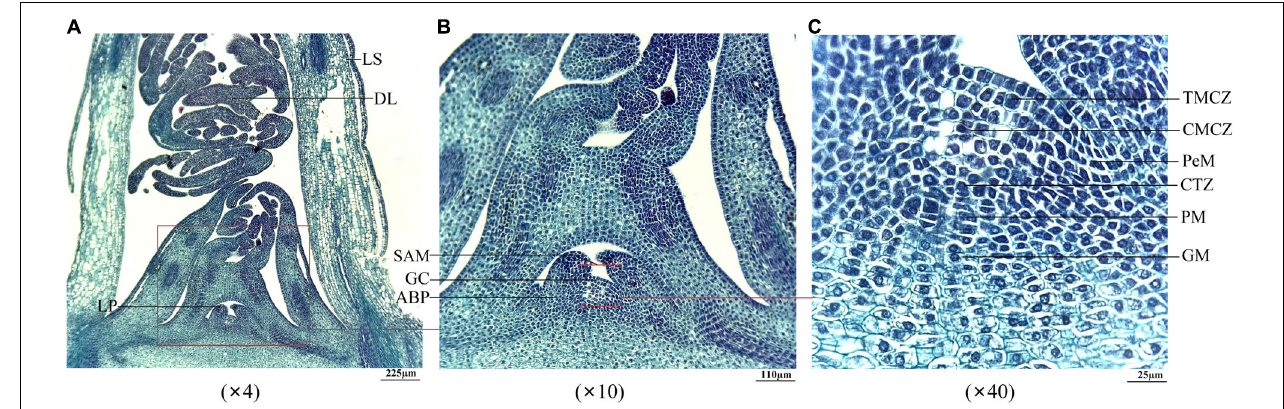
FIGURE 5 | Longitudinal anatomical structure of the SAM of seedlings of Angelica sinensis . Panels (A–C) represent the structure at 4 × , 10 × , and 40 × magnification of the large size at the − 5 ◦ C for 25 d, respectively. LS, leaf sheath; DL, delicate leaf; LP, leaf primordium; GC, growth cone; ABP, axillary bud primordium; TMCZ, tunica mother cell zone; CMCZ, central mother cell zone; PeM, peripheral meristem; CTZ, cambium-like transition zone; PM, pith meristem; GM, ground